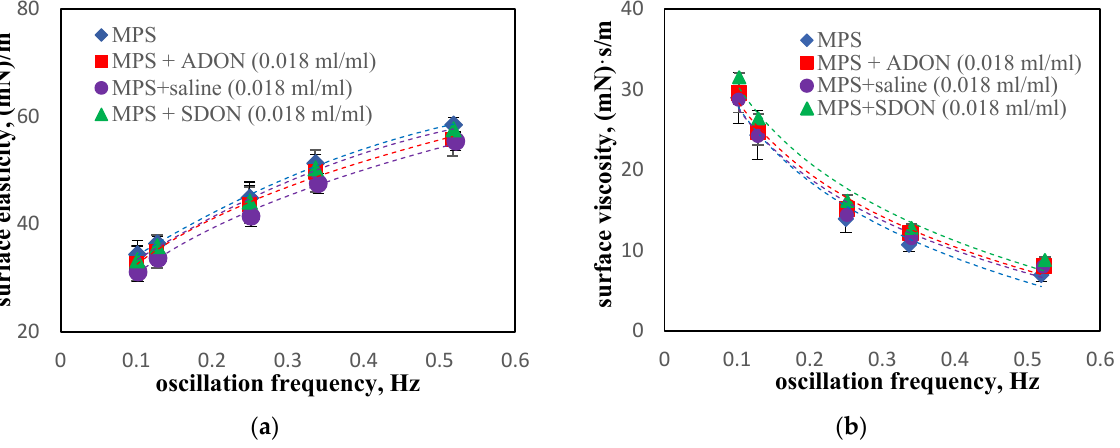
Figure 6. Dilatational surface elasticity ( a ) and viscosity ( b ) of air–water or air–saline interface in presence of MPS and ADON or SDON.